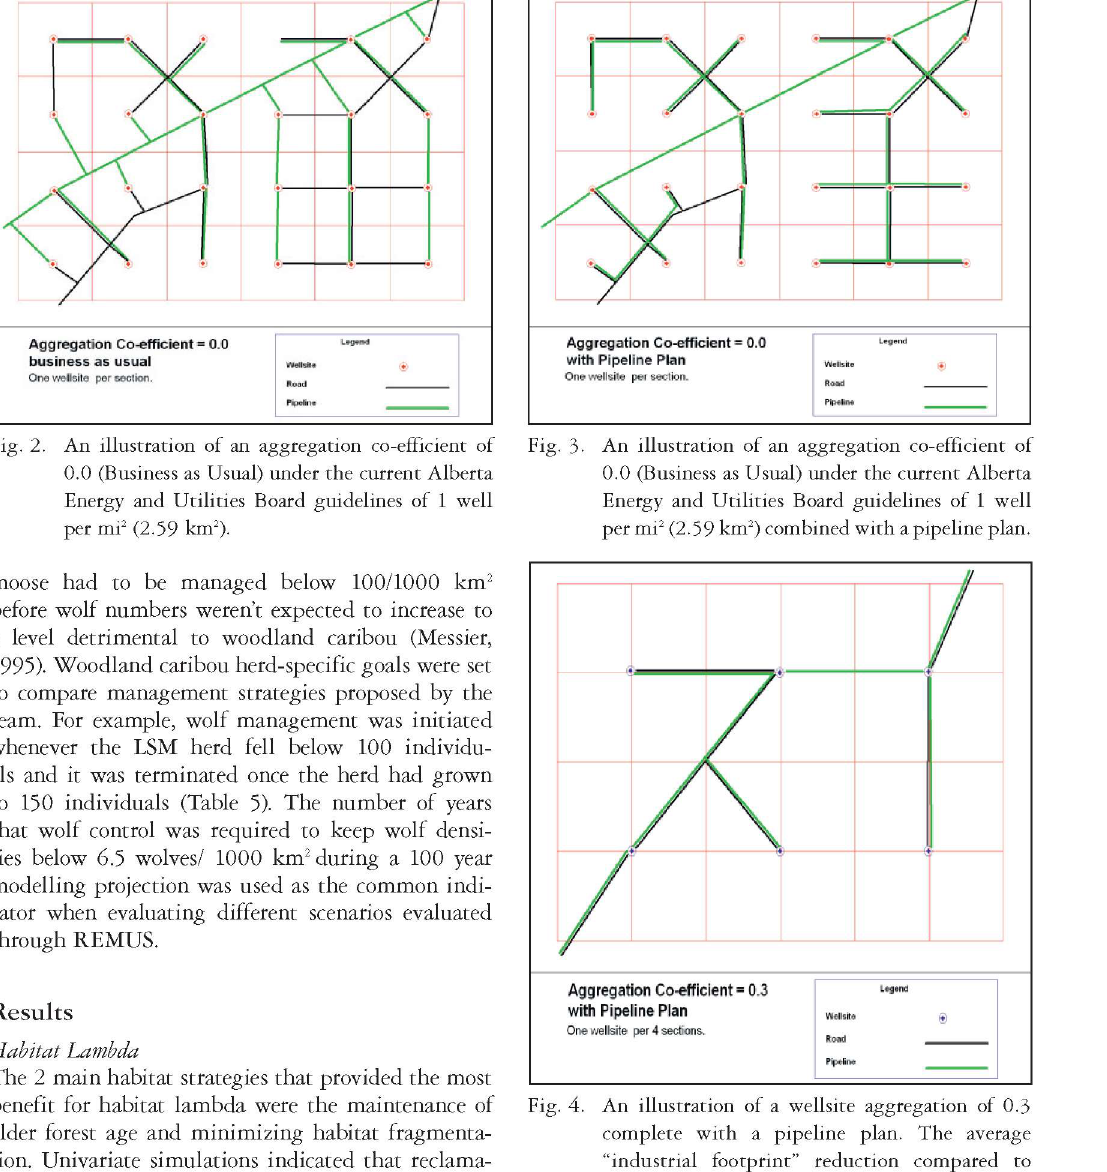
Fig. 4. An illustration of a wellsite aggregation of 0.3 complete with a pipeline plan. The average "industrial footprint" reduction compared to Fig. 3 is